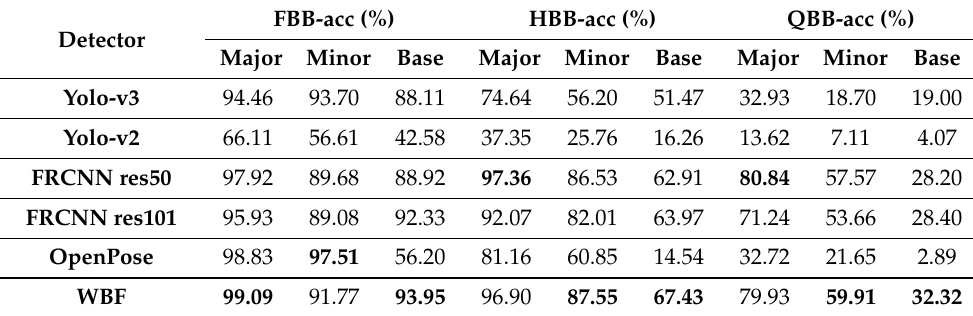
Table 5. Cross-dataset evaluation of 11k dataset with model M 1.